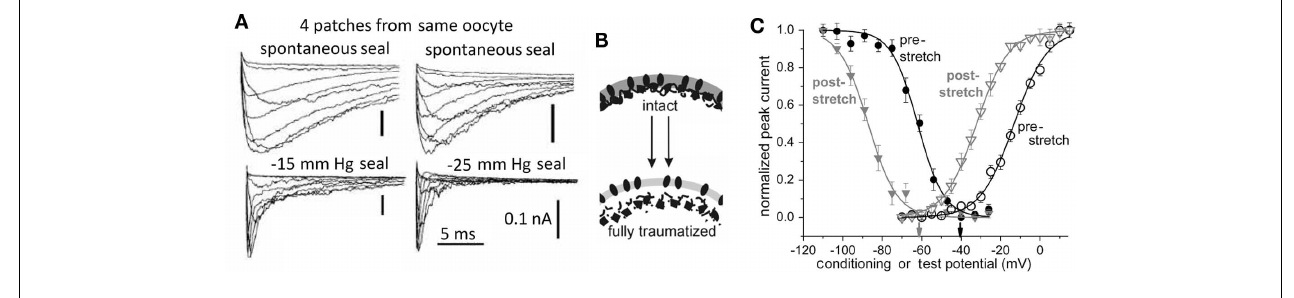
that is on average thinner and (not specifically depicted but indicated by the lighter color) more disordered/fluid/symmetric-across-leaflets. In oocytes, Nav1.5 channels behave as if they are trafficked to disordered membrane (Morris and Juranka, 2007a;Wang et al., 2009; Banderali et al., 2010) and so do not show irreversible kinetic changes with stretch, but in HEK cells, stretch is largely traumatic for Nav1.5 channels (Beyder et al., 2010). (C) The trauma phenomenon also occurs for Nav1.6 in oocyte membranes and is summarized by coupled left-shift of the activation and steady-state inactivation curves as shown here (seeWang et al.,